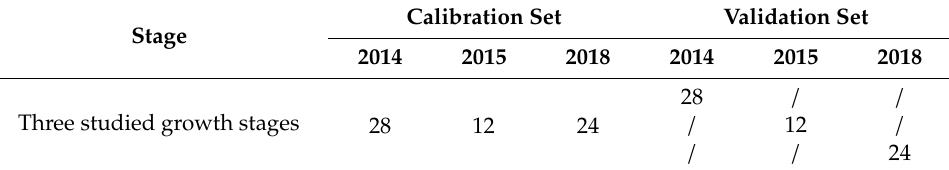
Figure 3. The distribution of region of interest (ROI) marked by the red rectangle frame. (a) Top part of the leaf; (b) middle part of the leaf; (c) bottom part of the leaf. Table 3. The number of samples used in calibration and validation for the three studied growth stages. Calibration Stage